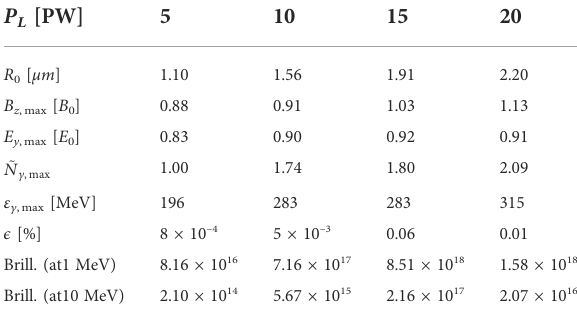
FIGURE 7 Conversionef fi ciency ofthe laser energy( τ =40 fs) impacting a Z =1 H + -plasmaintoahigh-energy γ -raybeam ( ≥ 10MeV ) witha beam width of ΔΘ =20 ° in percentages of the total energy for simulations carried out for Heppe